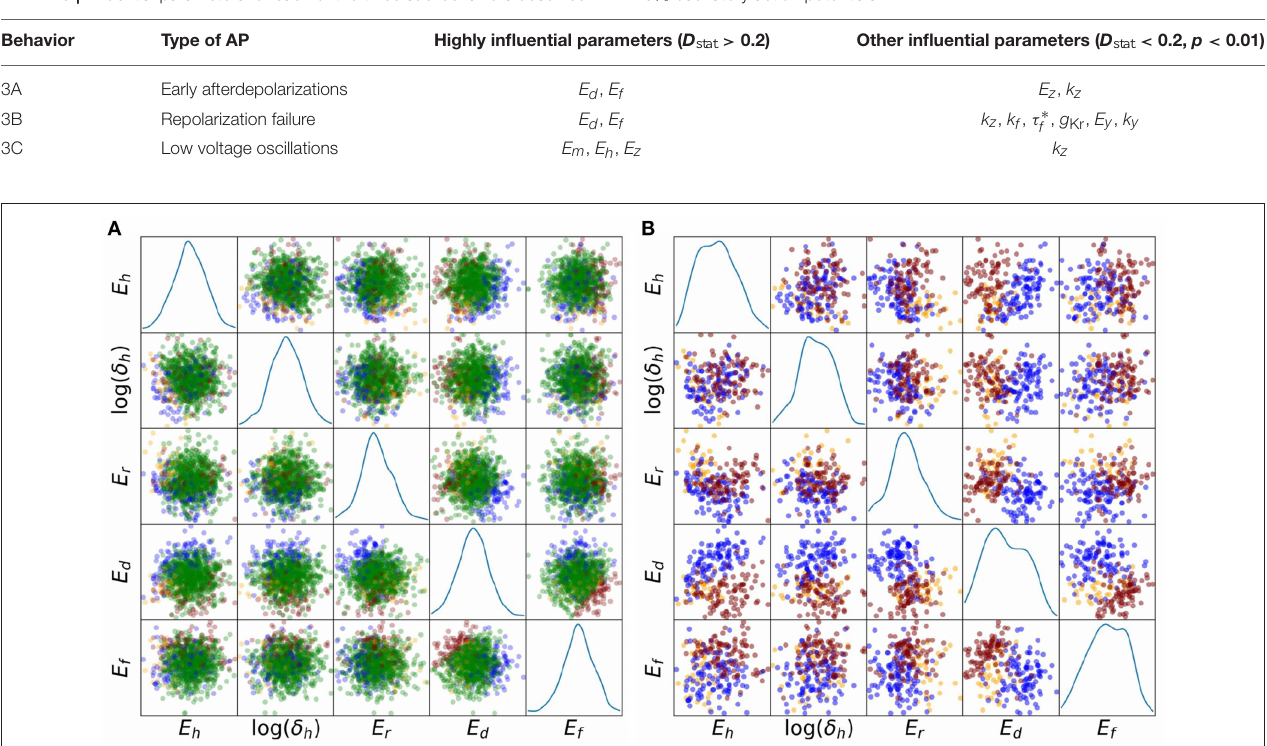
FIGURE 8 | Scatter plots of parameter values, colored by behavioral class, for ˆ σ = 5 % results, representing relatively large uncertainty in all parameters. Five important parameters are plotted, E h , δ h , E r , E d , E f . These were identified using behavioral analysis (see text). Blue points: points in parameter space for which APs display spike but no dome; orange points: APs display dome but no spike; red points: APs are oscillatory; green points: APs are normal. (A) All points. (B) Points corresponding to non-normal APs only. The underlying APs are shown in Figures 6D,E